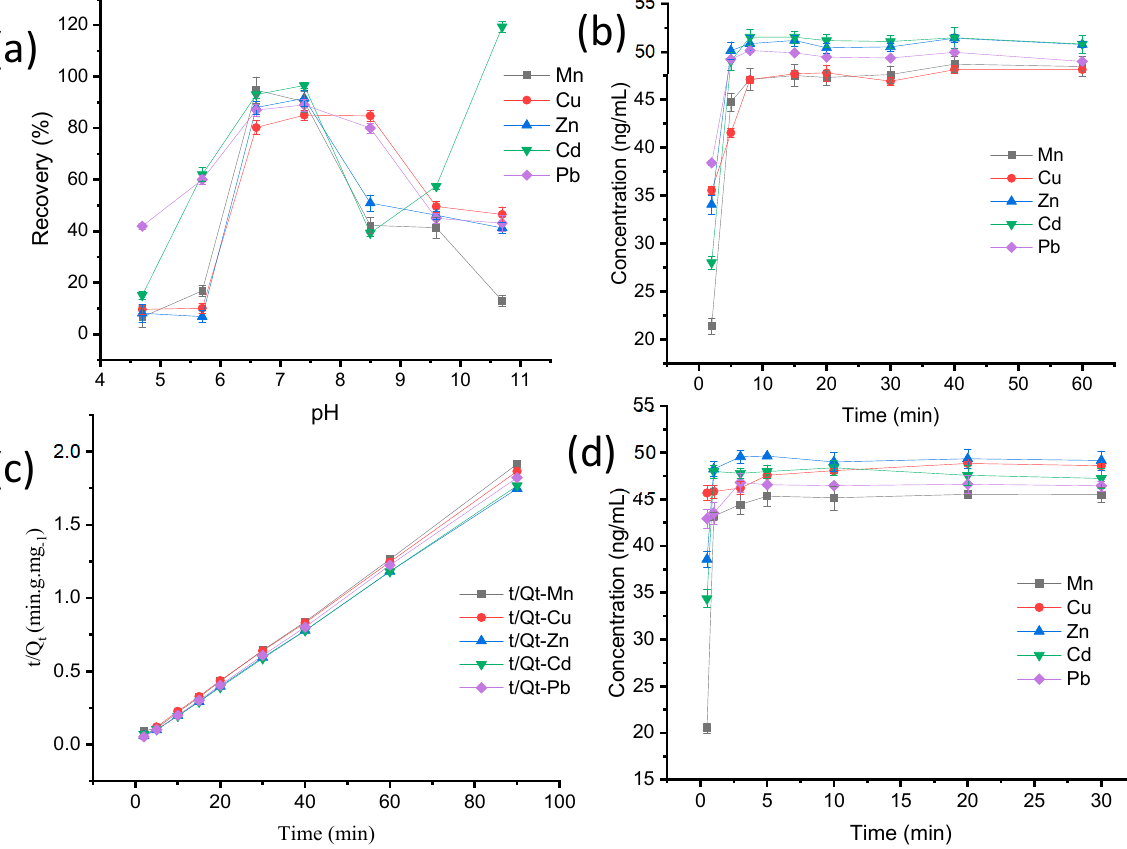
Figure 3. ( a ) Effect of initial solution pH; ( b ) Effect of adsorption time; ( c ) Pseudo-second-order kinetic model for adsorption; ( d ) Effect of the eluent time for Mn, Cu, Zn, Cd, and Pb.